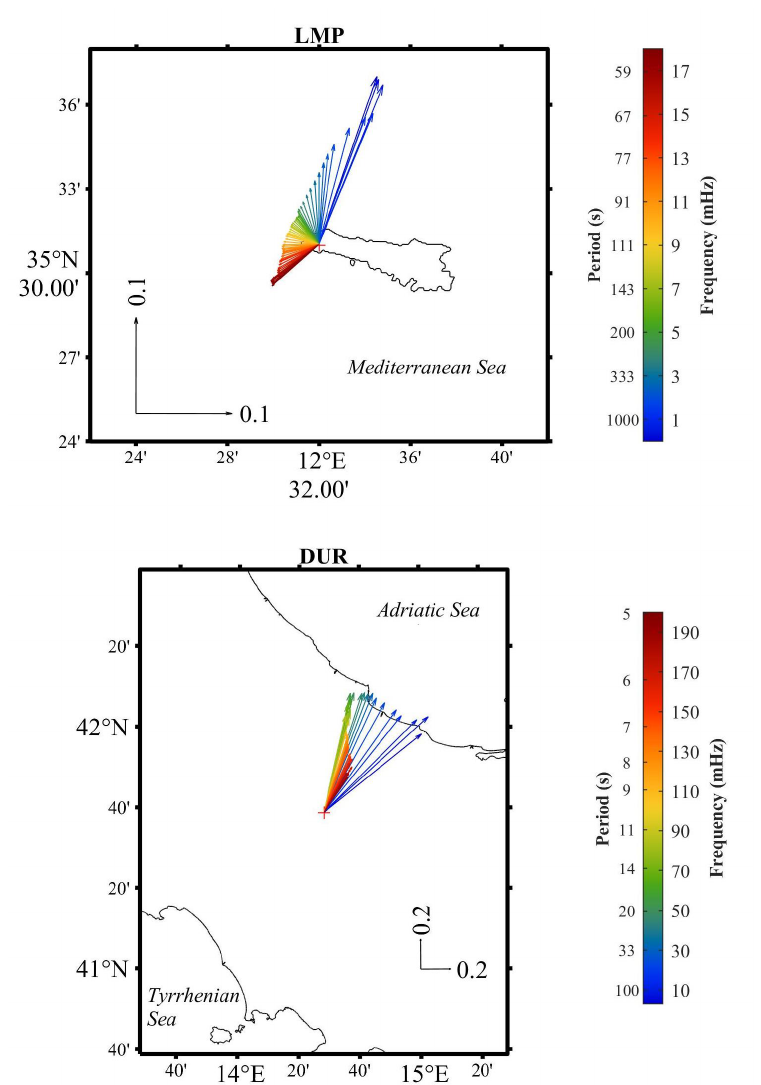
Figure 5. Single-station induction arrows, for real V ( r ) , at LMP ( top panel ) and DUR ( bottom panel ) in 2018 and in the reliable frequency/period range (see text for details). The origin of induction arrows corresponds to the observatory position. The frequencies are indicated by colorbars, while the reference amplitude of 0.1 and 0.2 length for the arrows are shown as segments along both longitude and latitude. Map produced by M_Map software